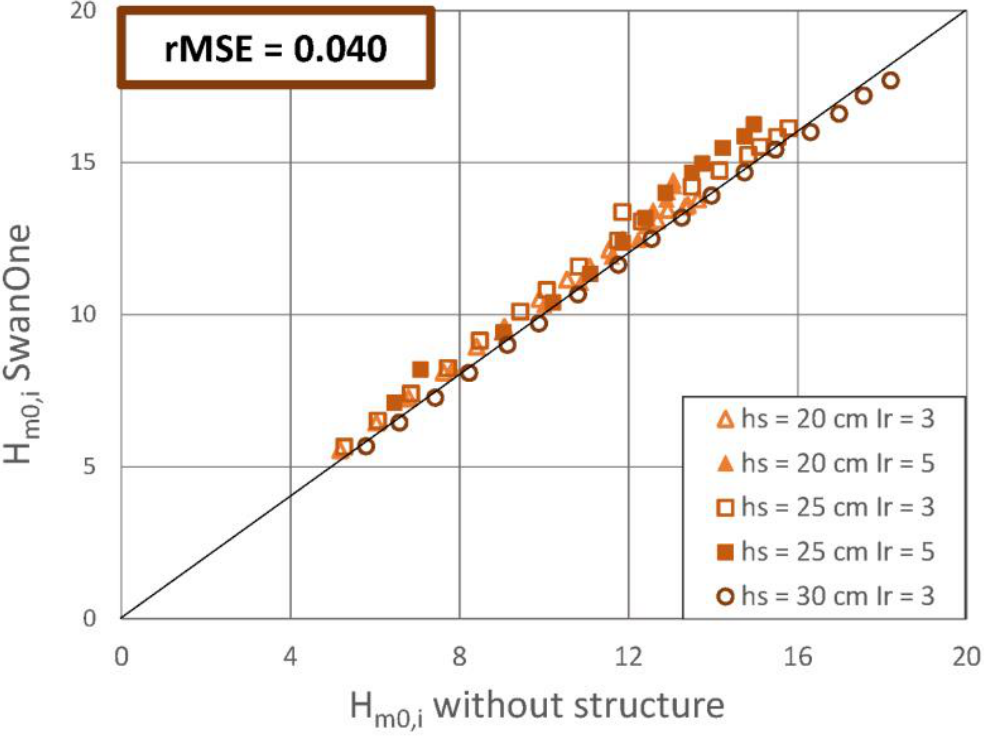
Figure 4. Comparison of H m0,i measured without structure and estimations given by SwanOne in the model zone.